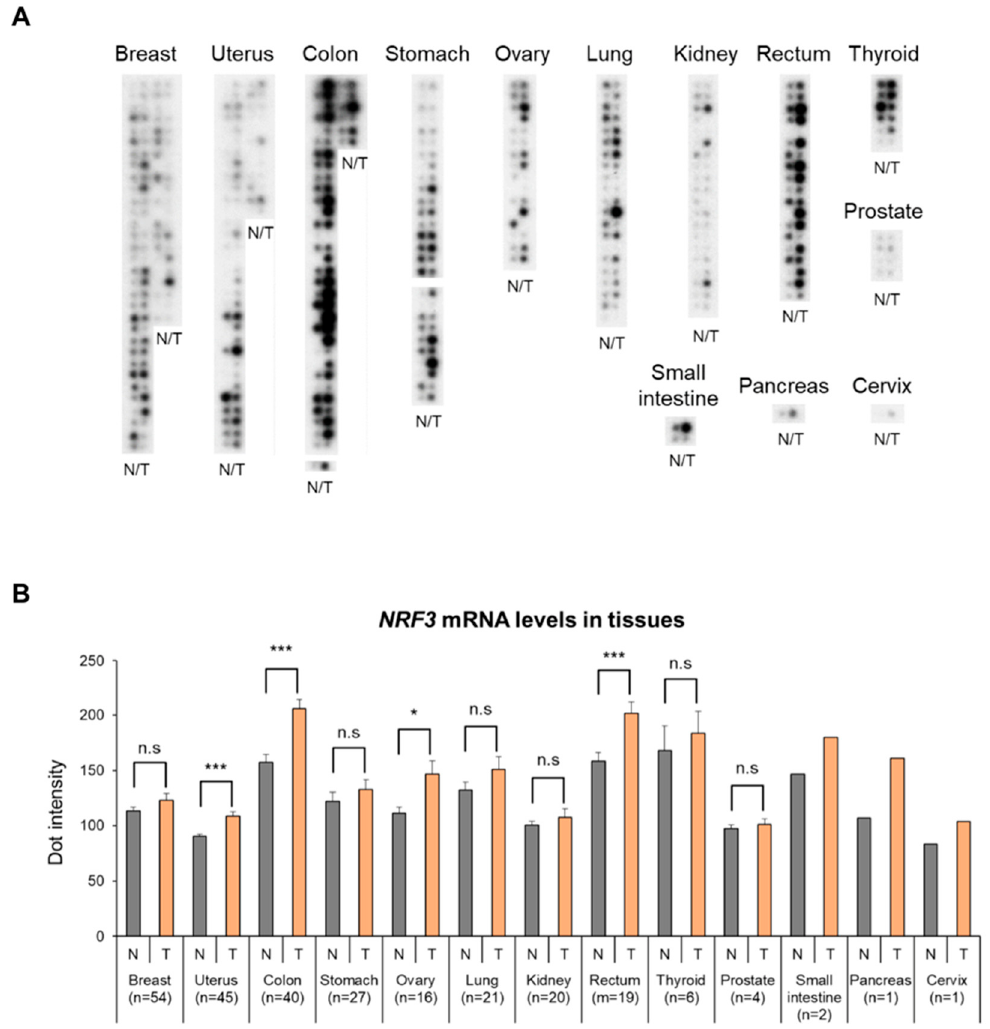
Figure 1. High induction of NRF3 gene expression in human tumor tissues. ( A ) RNA dot blot analysis of NRF3 using the Human Multiple Tissue Expression (MTE TM ) Array. This array contains dots of polyA + RNA from 76 different human tissues, normalized to ubiquitin mRNA levels. T; tumor tissue, N; adjacent normal tissue. ( B ) The bar graph shows the quantified signal intensity of each dot. The data are presented as the mean ± SD. n , patient number. * p < 0.05, *** p < 0.005 ( t -test). n.s., not significant.